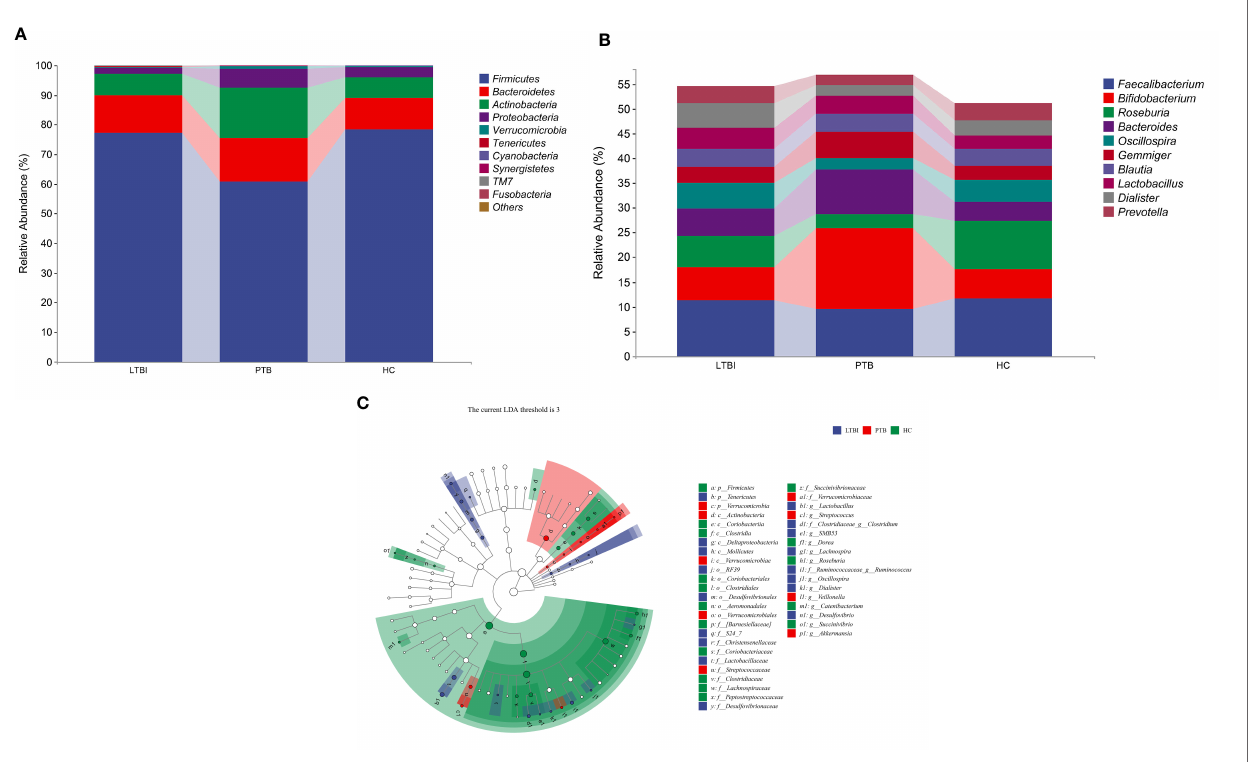
FIGURE 3 | Taxonomic features of the fecal microbiota of patients in three groups. (A) The distribution of three groups at phylum level of top 10 species. (B) The distribution of three groups at genus level of top 10 species. (C) Cladogram is a taxonomic diagram showing the taxonomic hierarchy of the signi fi ed species in each group of samples by